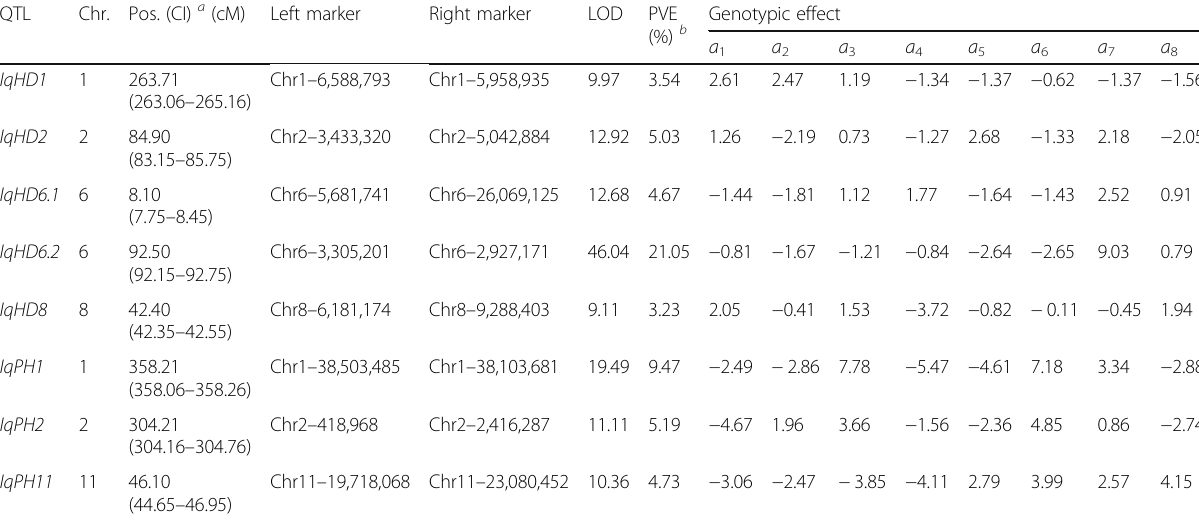
Table 5 QTLs for heading date and plant height based on the integrated map in 8PL QTL Chr. Pos. (CI) a (cM) Left marker Right marker